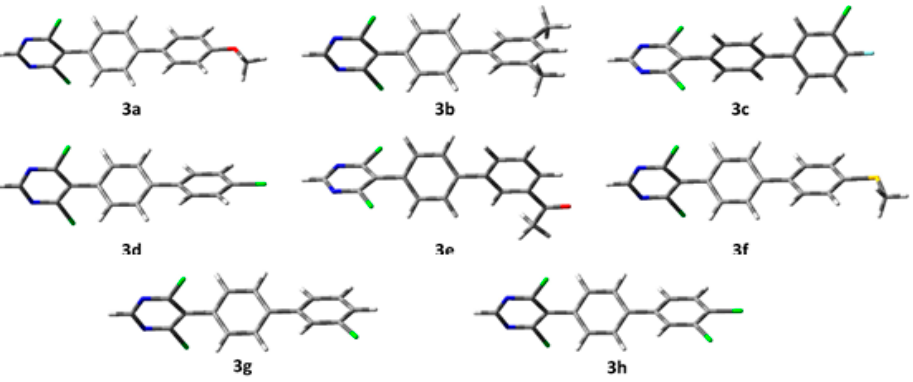
Figure 2. Optimized structures of derivatives ( 3a–3h ) at the PBE0-D3BJ / def2-TZVP / SMD water level of theory. In 3D models, gray color denotes carbon, white signifies hydrogen, red symbolizes oxygen, green represents chlorine, blue displays nitrogen and brown is for bromine atoms. Processes 2020 , 8 , x FOR PEER REVIEW